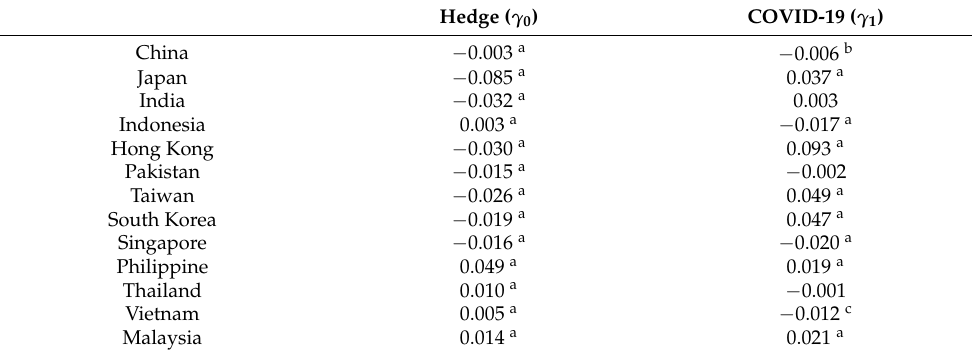
Table 3. Estimation results for the hedge and safe-haven properties of gold against Asian equities in the COVID-19